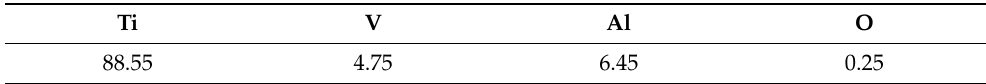
Figure 10. ( a ) Humeral implant containing a lattice structure; ( b ) SEM image of the manufactured Ti lattice structure. Table 5. EDS analysis of the fabricated implant. Table 5. EDS analysis of the fabricated